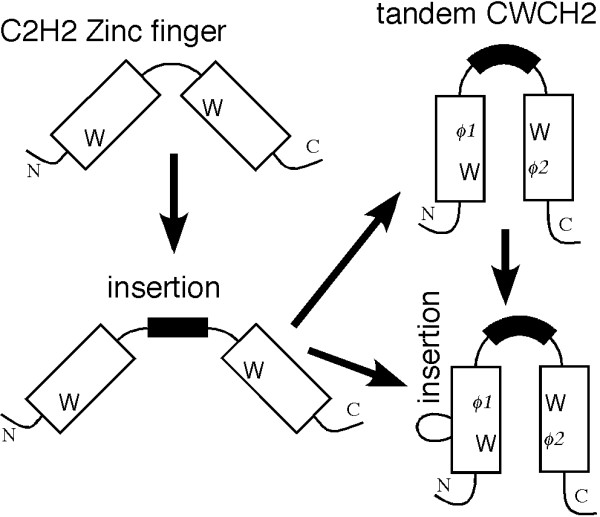
Evolution of the tCWCH2 domain. We propose that the tCWCH2 patterns were generated from classical C2H2 sequences concurrently with the acquisition of the additional sequence features.